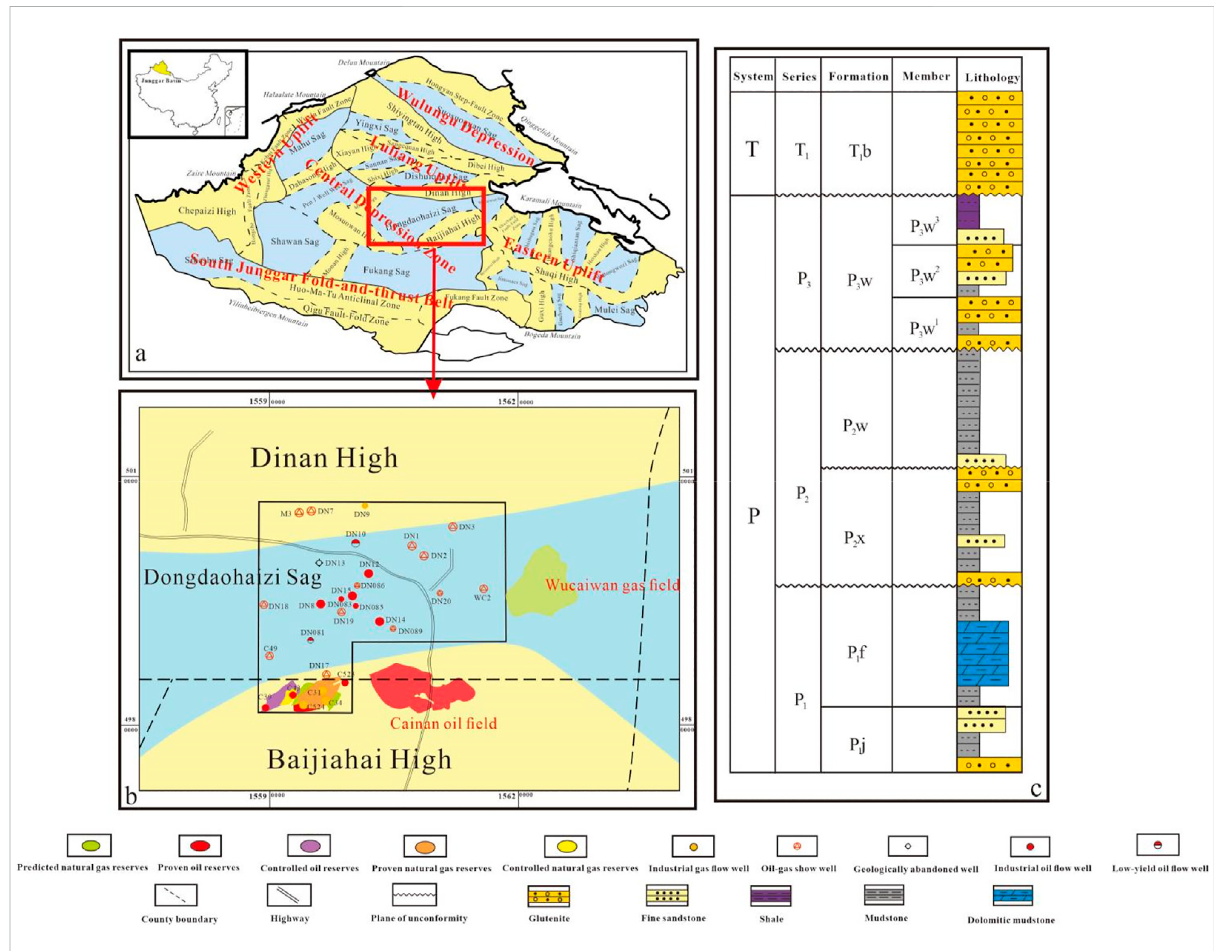
FIGURE 1 Basic regional pattern and comprehensive stratum column chart of study area. (A) Geographic location and Paleogene structure block plan of Dongdaohaizi Sag of the central depression, Junggar Basin; (B) Location of the Dinan 15 well in the study area; (C) Comprehensive column chart of the Upper Permian series, Junggar